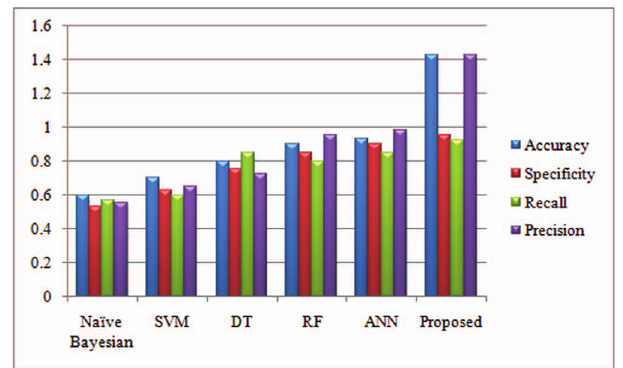
Fig. 20. Statistic evaluation of proposed using existing system through island for 50 trials.